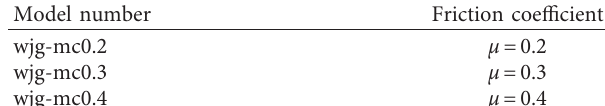
Table 8: Group C models.